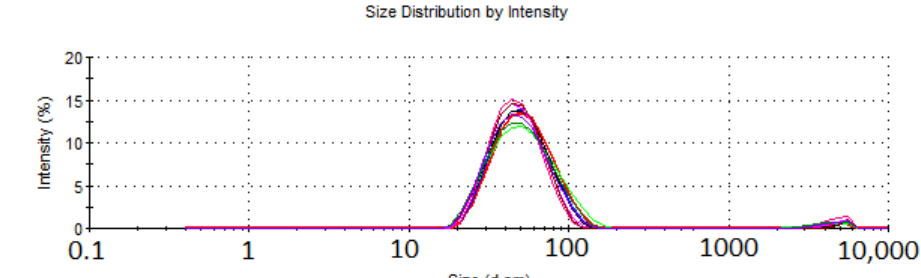
Figure 6. Droplet size and polydispersity index (PDI) of the optimized formulation, as measured by photon correlation spectroscopy.